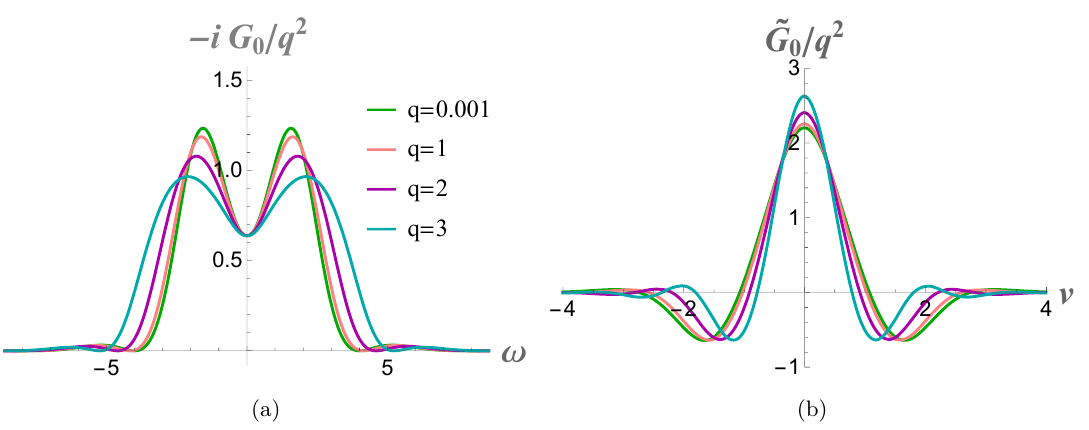
Figure 7 . (a) The ω -dependence of − iG 0 ( ω ) /q 2 at fixed q -slices; (b) the inverse Fourier transform of − iG ( ω ) /q 2 at fixed q 0